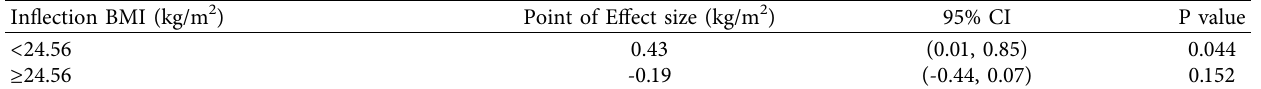
Table 4: Results of BMI and cognitive function using two piecewise linear regression.